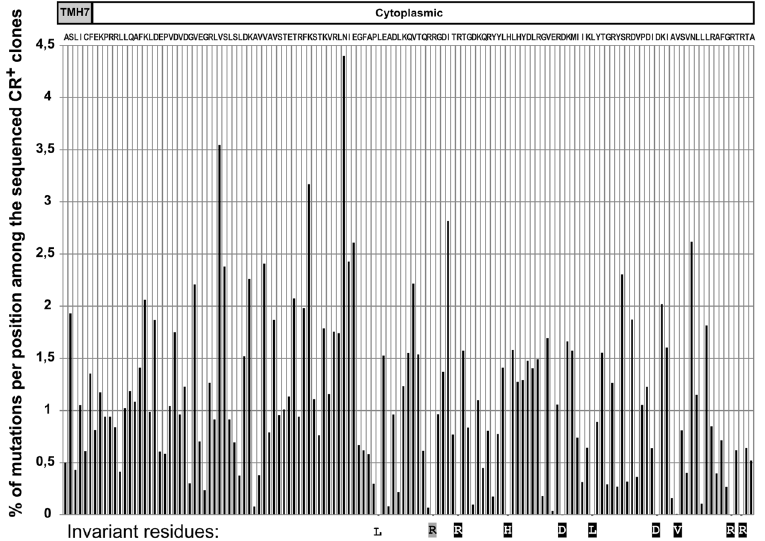
Figure 3. Random mutagenesis of the C-BgsA domain. After error-prone PCR mutagenesis, the C-BgsA domains of one thousand clones retaining MLG production (CR + , see text) were Illumina deep sequenced. In the figure, the proclivity of every position in C-BgsA to be mutated without affecting MLG production is indicated as the rate (%) of mutations. Last predicted transmembrane helix (TMH7) is shown. The BgsA sequence is indicated on the top, and the invariant residues (0% of changes) in the mutagenized CR + population are shown at the bottom of the graph. Color background of these invariant residues indicate their conservation in BgsA orthologous sequences available in data bases (black, fully conserved; grey, highly conserved; white, not conserved; see also Supplementary Fig.